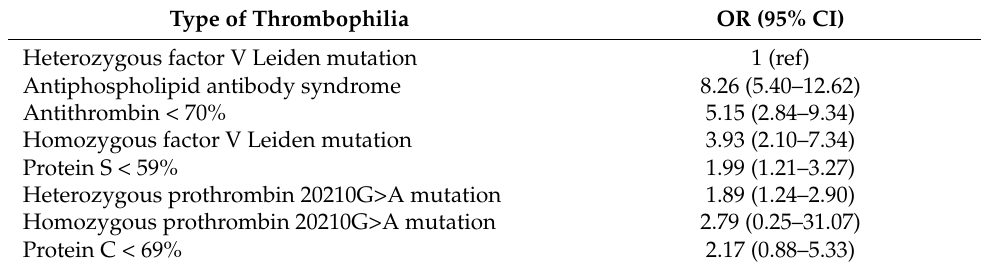
Table 4. Influence of the type of thrombophilia on